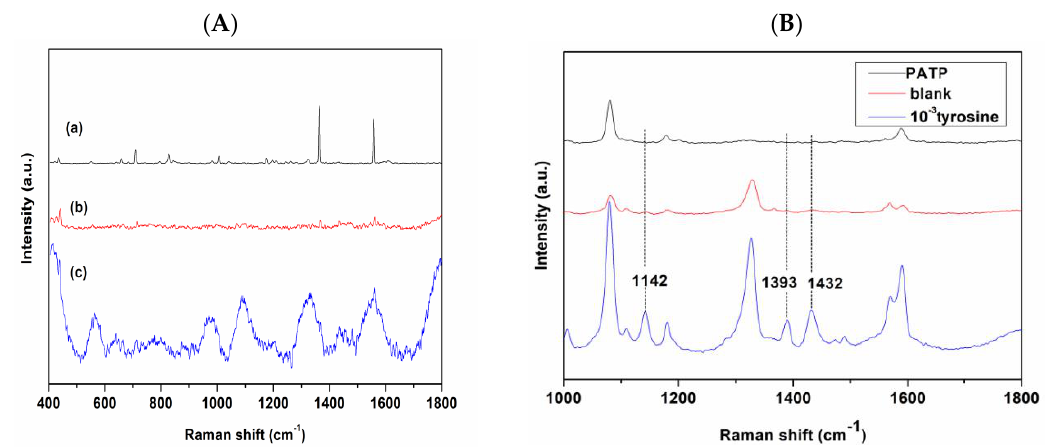
Figure 6. (A) Raman spectra of (a) Tyr solid; (b) Tyr (10 −3 M) in AgNCs; and (c) AgNCs substrate; (B) Figure 6. ( A ) Raman spectra of ( a ) Tyr solid; ( b ) Tyr (10 − 3 M) in AgNCs; and ( c ) AgNCs substrate; SERS spectra of azo dye-derived from Tyr at 10 −3 M, 10 −3 M p -amino thiophenol (PATP) aqueous ( B ) SERS spectra of azo dye-derived from Tyr at 10 − 3 M, 10 − 3 M p -amino thiophenol (PATP) aqueous solution, and control blank sample without Tyr. solution, and control blank sample without